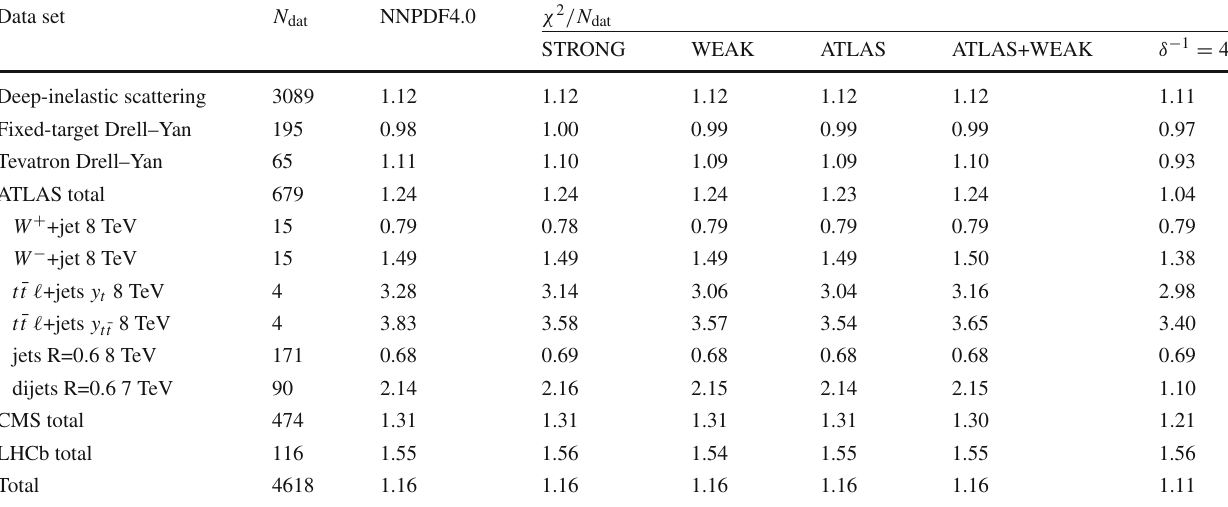
Table 3 The number of data points, N dat , and the χ 2 per data point, χ 2 / N dat , for the NNPDF4.0 NNLO baseline fit, for each of the fits performed with a different correlation model (see text for details), and for the fit to the NNPDF4.0 data set regularised with δ − 1 = 4